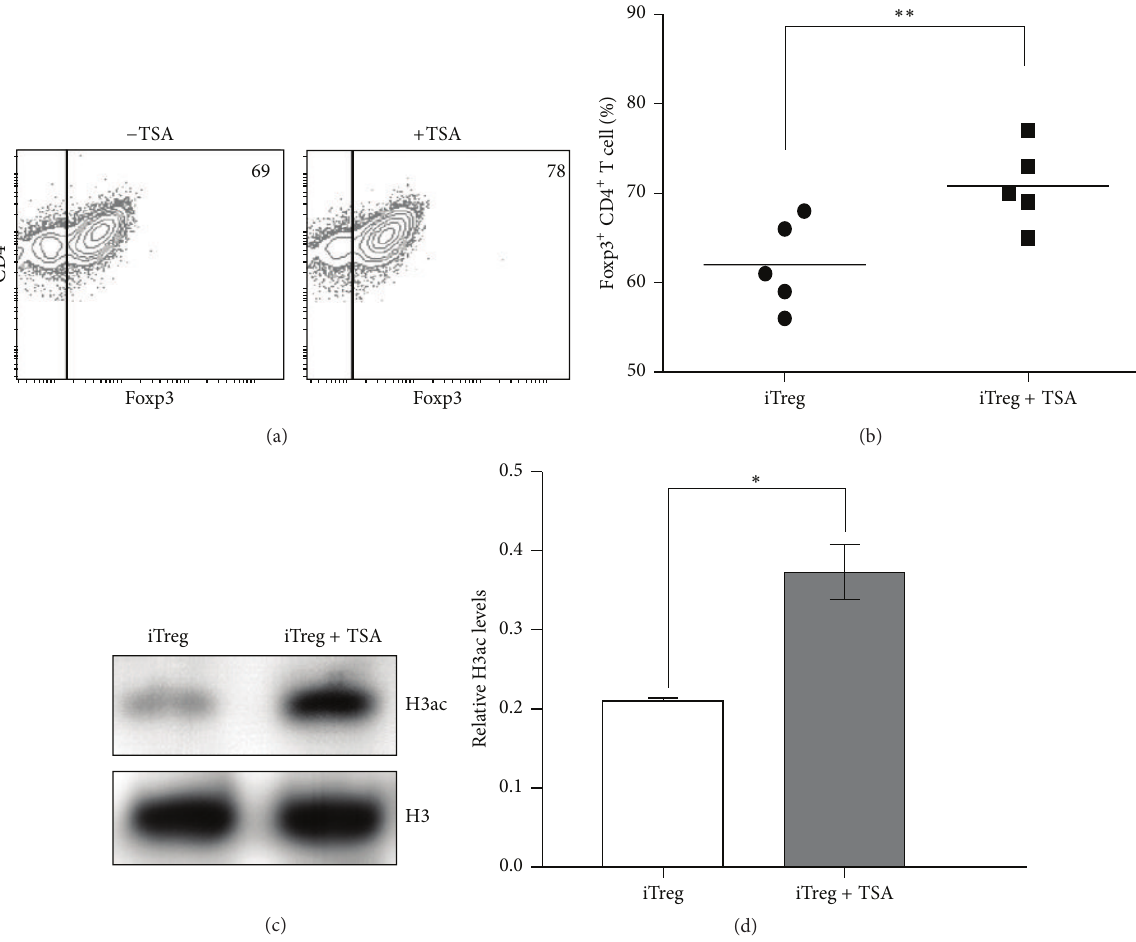
Figure 2: TSA increases the generation of Tregs from naive CD4 + T cells. (a) Flow cytometry analysis of CD4 + Foxp3 + cells generated in the absence (left) or presence (right) of 10nM TSA for 4 days. Numbers indicate the percentage of CD4 + Foxp3 + double positive cells. (b) Scatter plot depicts percentage of CD4 + Foxp3 + double positive cells from five independent experiments in the presence and absence of TSA. ∗∗ 𝑃 < 0.008 by student’s 𝑡 -tests. (c) Western blot analyses of total protein extracts derived from Tregs differentiated in the absence or presence of 10nM TSA, as indicated. (d) Quantitation of the acetylation levels relative to the histone H3 with the Quantity One software. Standard deviation was obtained from three independent experiments. ∗ 𝑃 < 0.05 by two-way